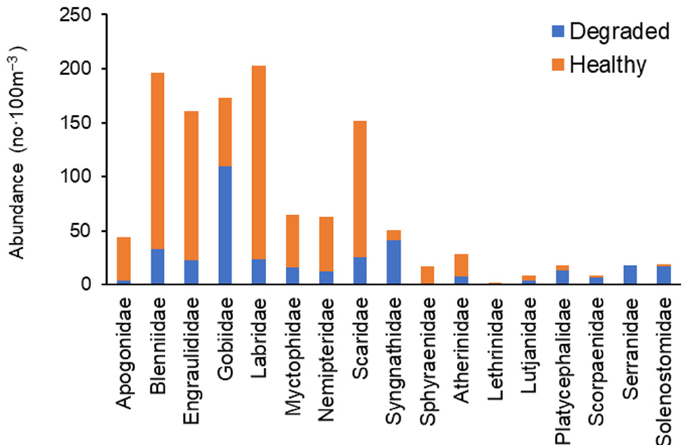
Figure 4. Composition and abundance of larval fish families in degraded and healthy seagrass hab- itats.